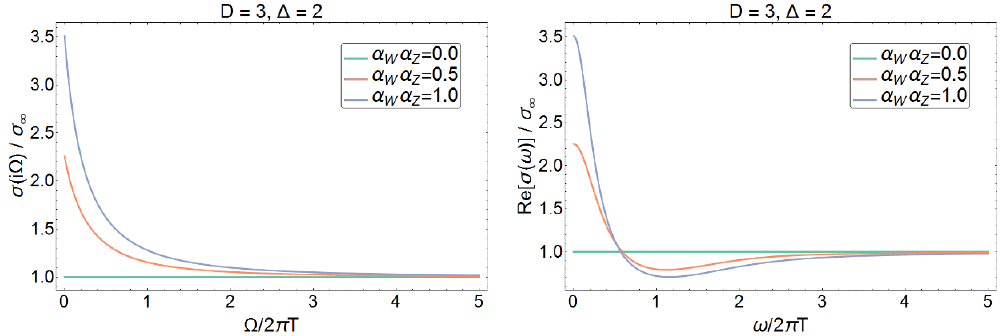
Figure 4 . The Euclidean (left) and real (right) AC conductivity for D = 3 and (cid:1) = 2 in the critical theory ( h = 0) for various choices of interaction strength (cid:11) W (cid:11) Z .